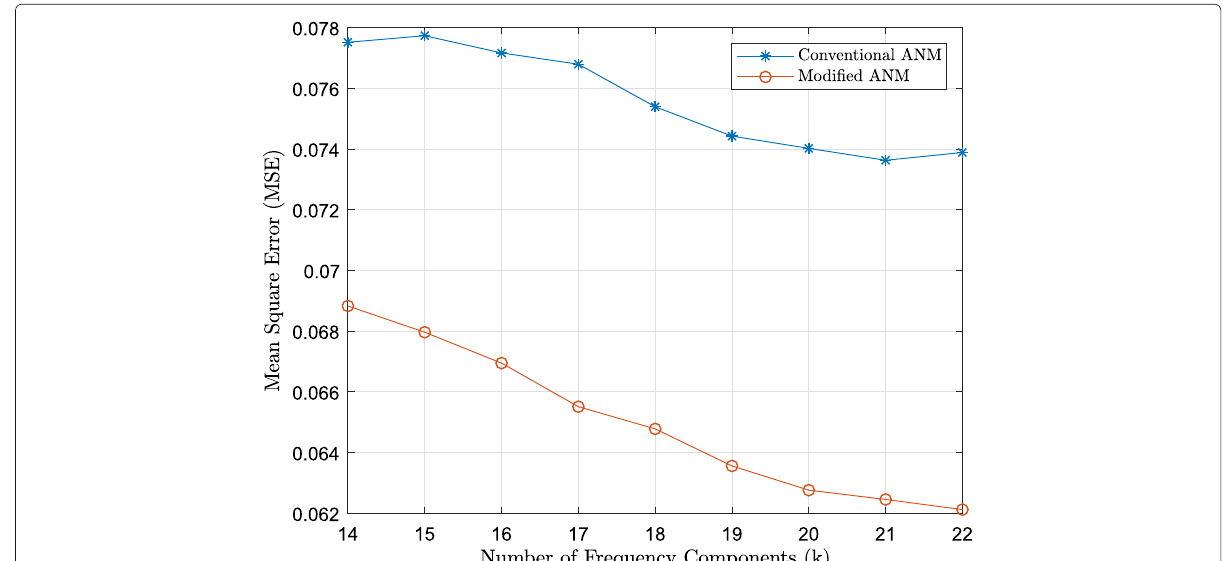
Fig. 5 MSE performance as a function of